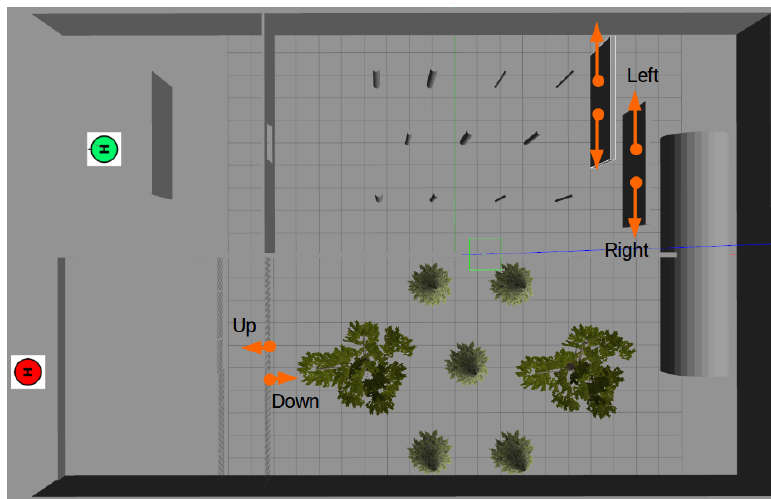
Figure 7. Dynamic training environment (top